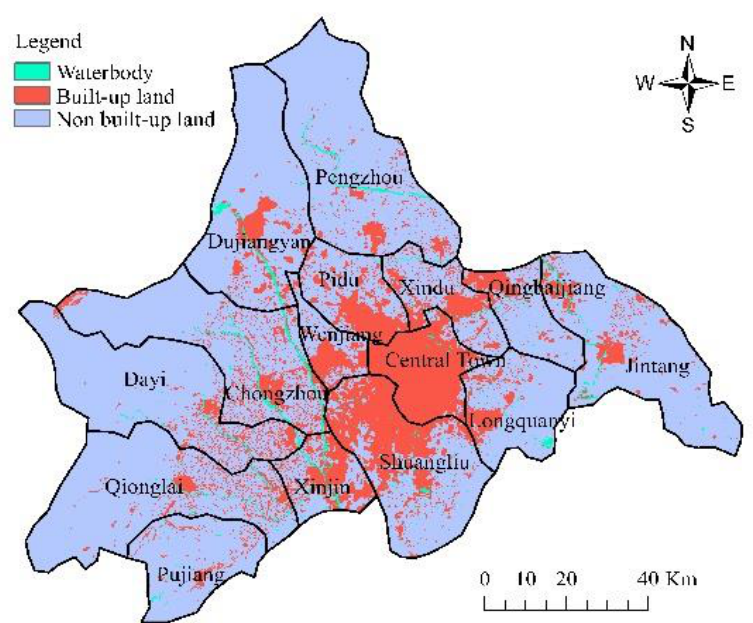
Figure 8. Simulation result of land use in 2025.